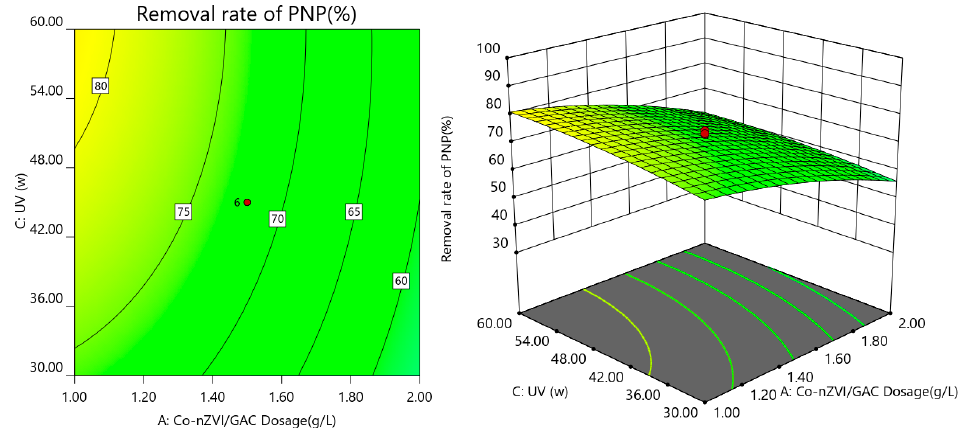
Figure 8. Response surface of the relationship between the Co-nZVI/GAC dosage and UV power.